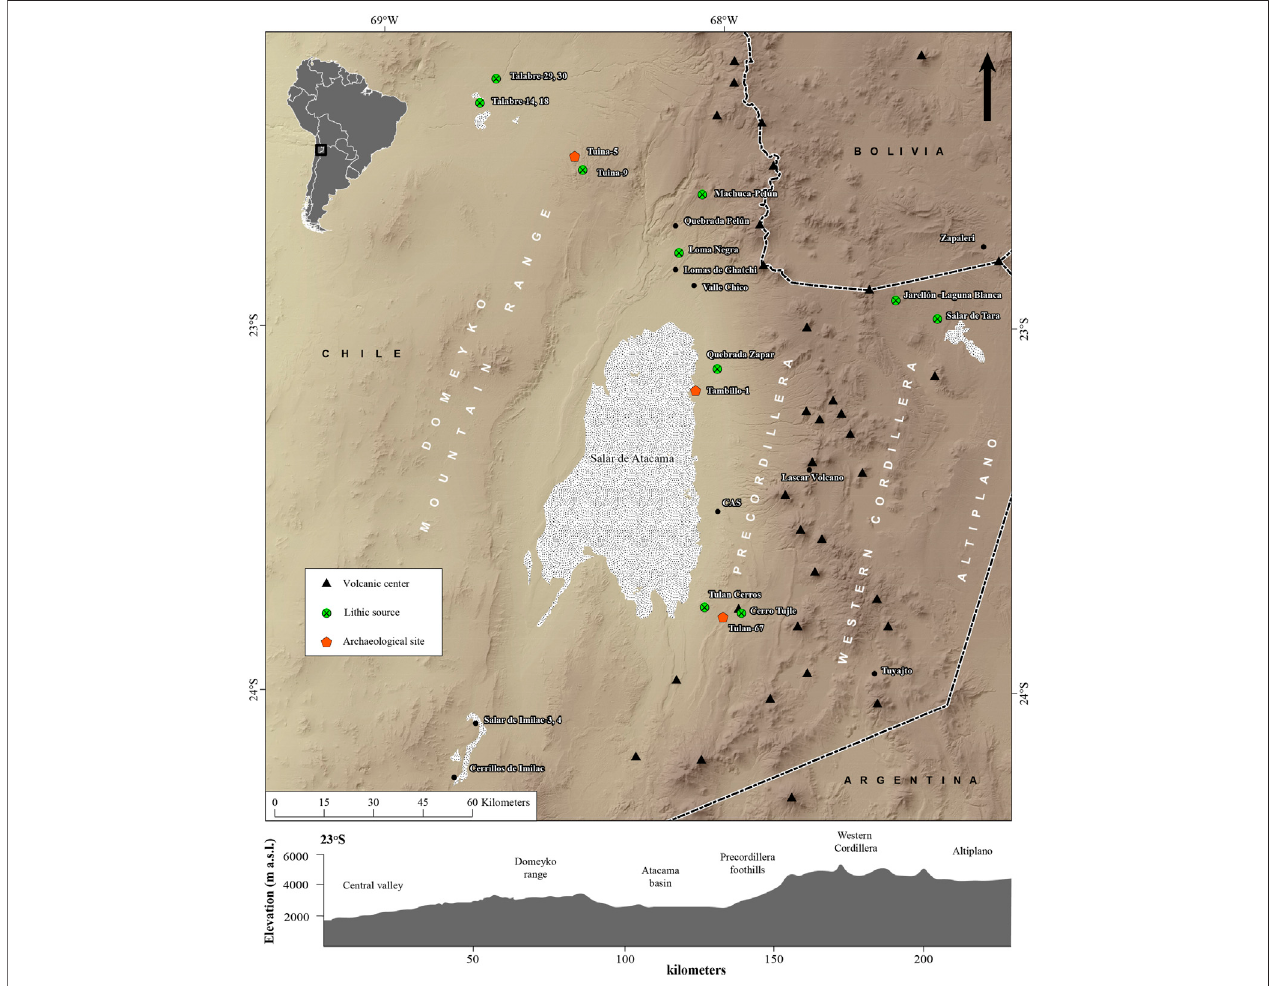
FIGURE 1 | Map of archaeological sites studied (red pentagons), lithic raw material sources (green circles), and principal volcanoes of the Atacama basin (black triangles).